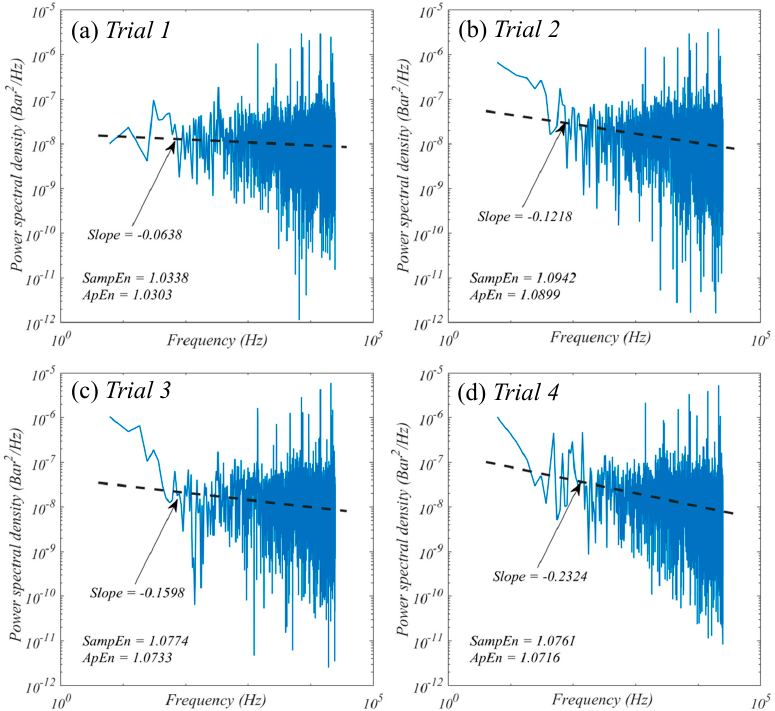
Figure 7. Power spectral density across frequency for four different discharges, ( a ) Trial 1, ( b ) Trial 2, ( c ) Trial 3, and ( d ) Trial 4 for point P 2, where β = slope of PSD (see details in (13)). The SampEn and ApEn numerical values are displayed within each